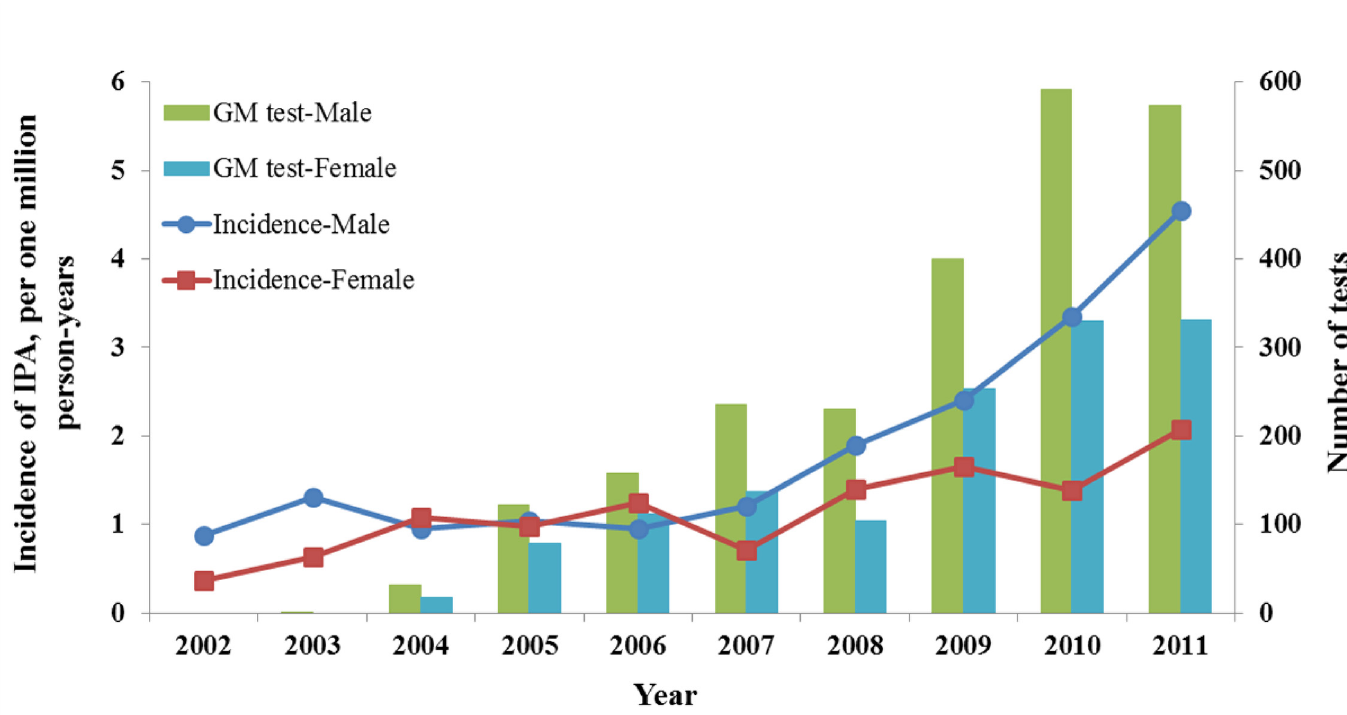
Fig 1. Correlation of the incidence of invasive pulmonary aspergillosis in different sex with galactomannan test utilization rate over